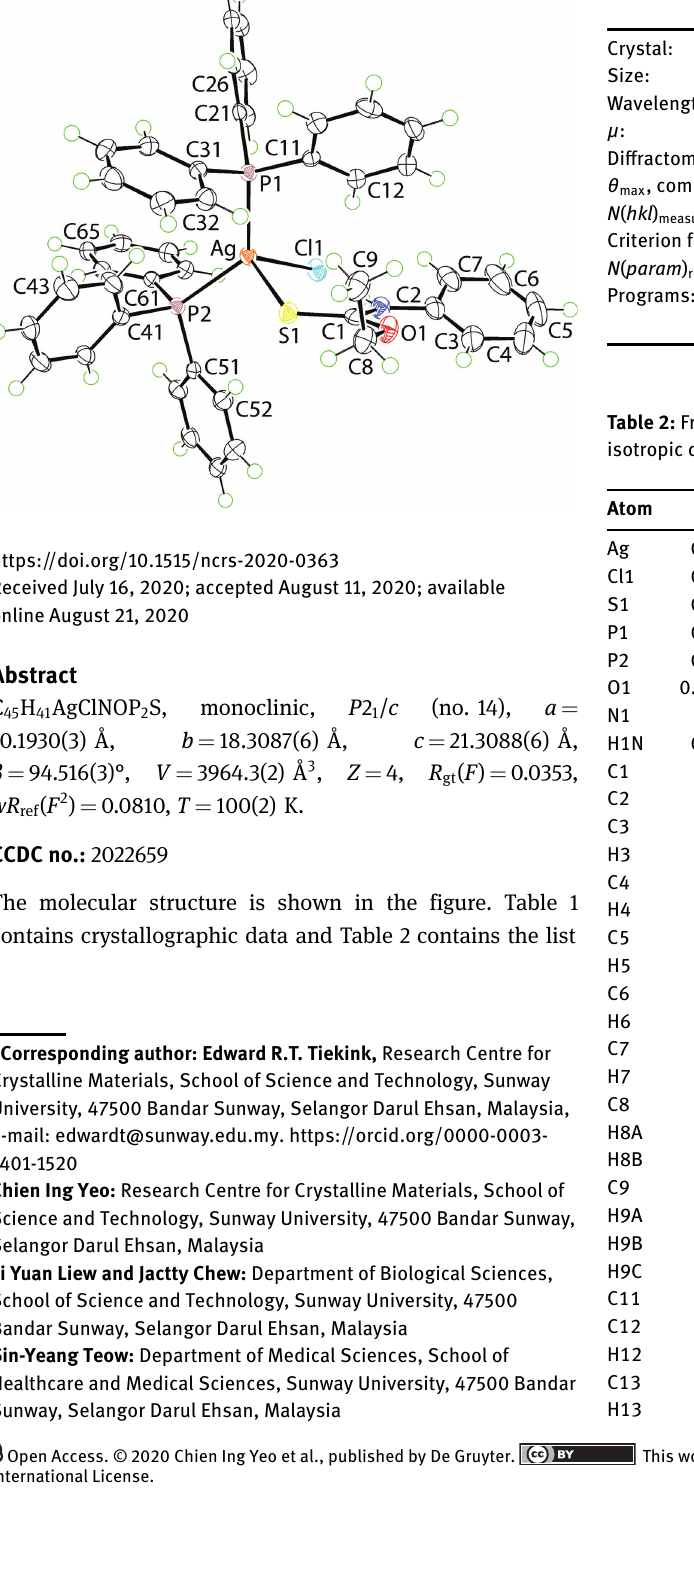
Table 1: Data collection and handling.